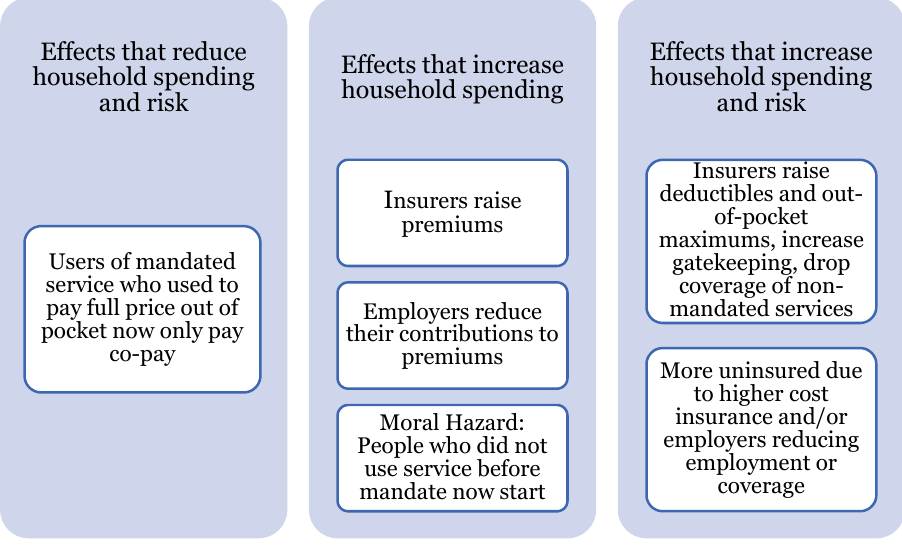
Figure 2. Effects of insurers covering a mandated service. Source: Created by author.